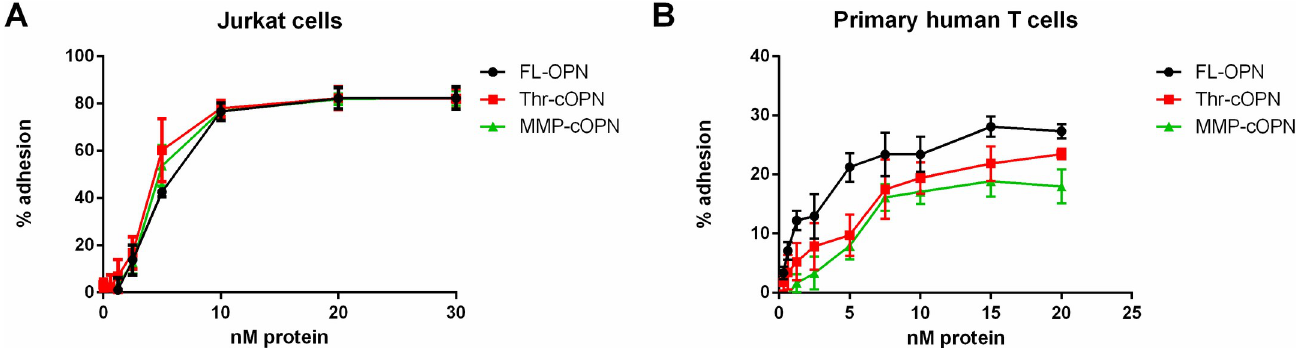
Fig 5. T cells bind to OPN. (A) Jurkat cells (2 experiments, each run in duplicate) and (B) primary T cells (4 experiments utilizing 4 donors, each run in duplicate) were analyzed for their adhesion to FL-OPN, Thr-cOPN and MMP-cOPN.